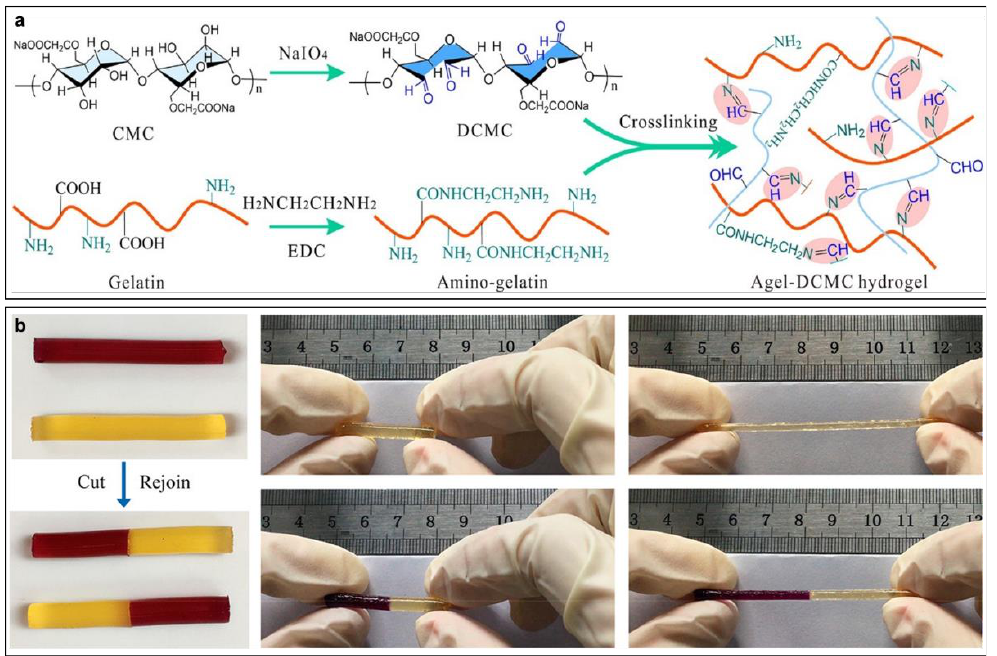
Figure 2. ( a ) Fabrication route of self-healing gelatin − cellulose (CMC) hydrogel based on the Schiff base reaction; ( b ) a cut hydrogel self-heals after rejoining; and the stretching ability of the healed hydrogel (reprinted with permission from ref. [36]).